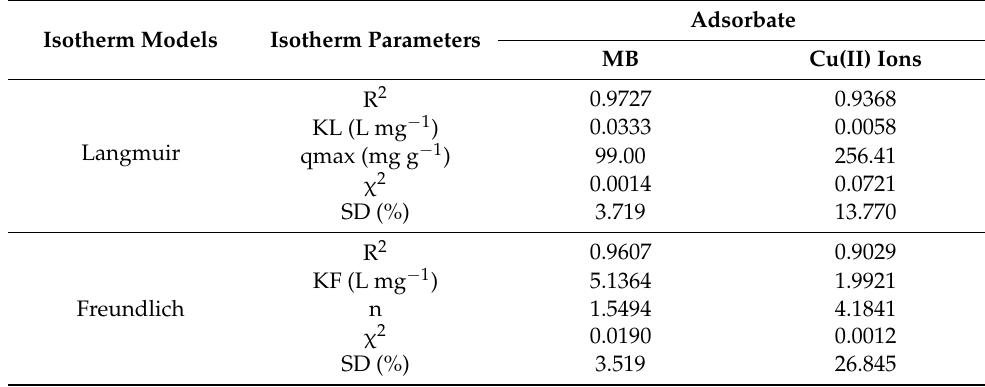
Table 2. Parameters of the fitting Langmuir and Freundlich isotherms for the adsorption of MB and Cu(II) ions onto the HGC-2